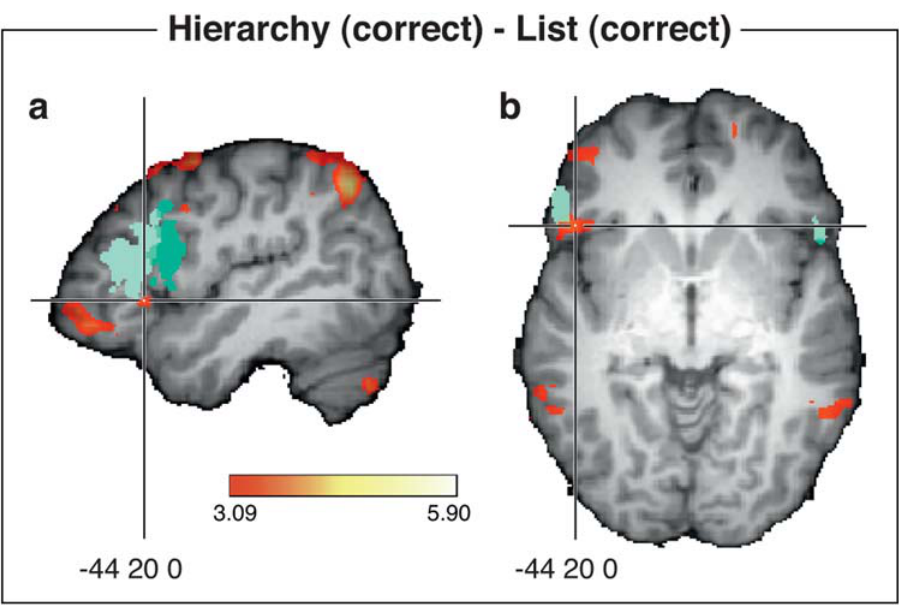
Figure 2. The figure shows activation for correct hierarchical syntactic formulae relative to a list of correct flat syntactical sequences. FMRI data are mapped onto a reference brain (single subject), where areas differing significantly in activation are coloured red to yellow and correspond to values with Z w 3 : 09 (uncorrected). The cross hair is placed at ( 2 44, 20, 0) in the Talairach co-ordinate system. Views: (a) sagittal x ~{ 44 and (b) axial z ~ 0 . The entire region marked in green in (a) and (b), corresponds to the cytoarchitectonically defined Broca’s area with a probability of at least 50% according to [13]. Light green corresponds to Brodmann area BA 45, and dark green to BA 44.